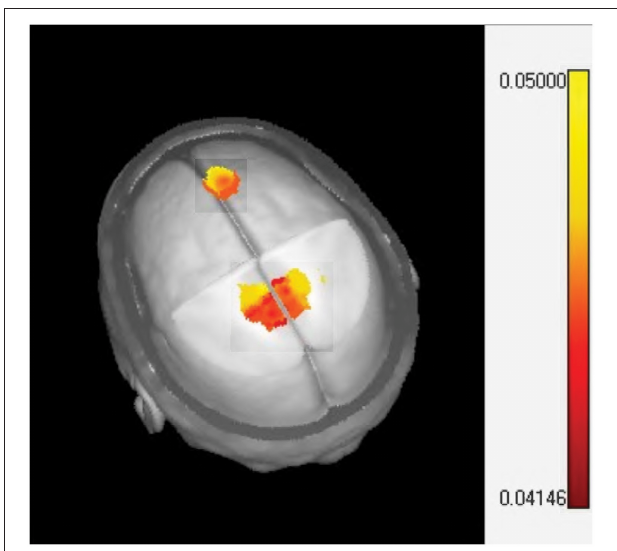
FIGURE 6 | Sources localization of the music therapy specific mismatch responses. The one sided t -test of LORETA images plotted on the MNI brain template identifying significant activation in the midcingulate (bilateral) and prefrontal